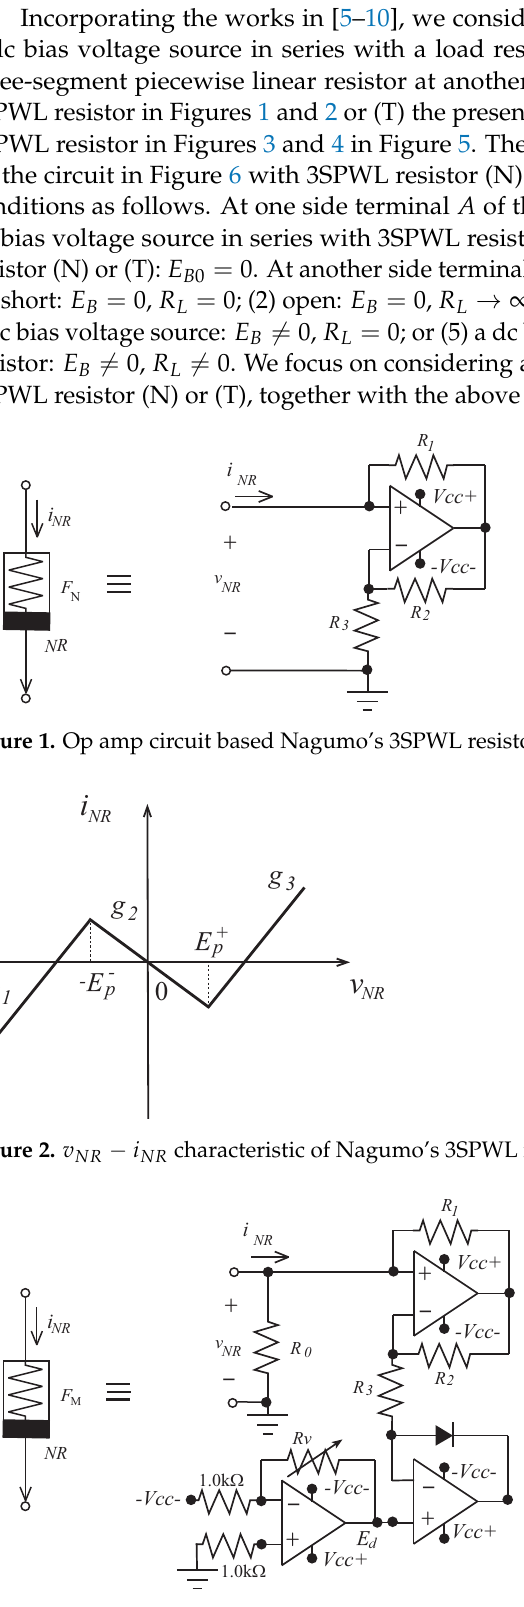
Figure 3. Op amp circuit based Modeled Tunnnel Diode 3SPWL